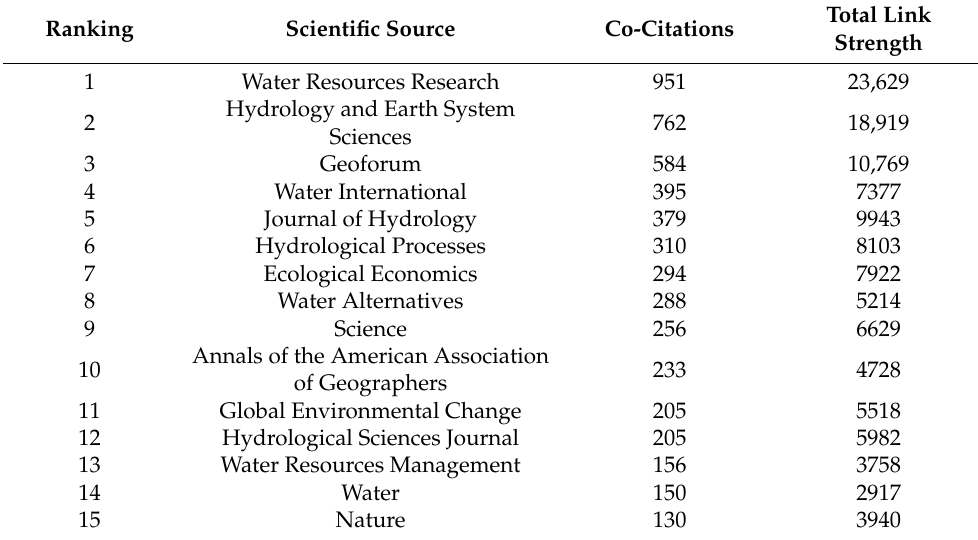
Table 5. Top 15 scientific sources co-cited on